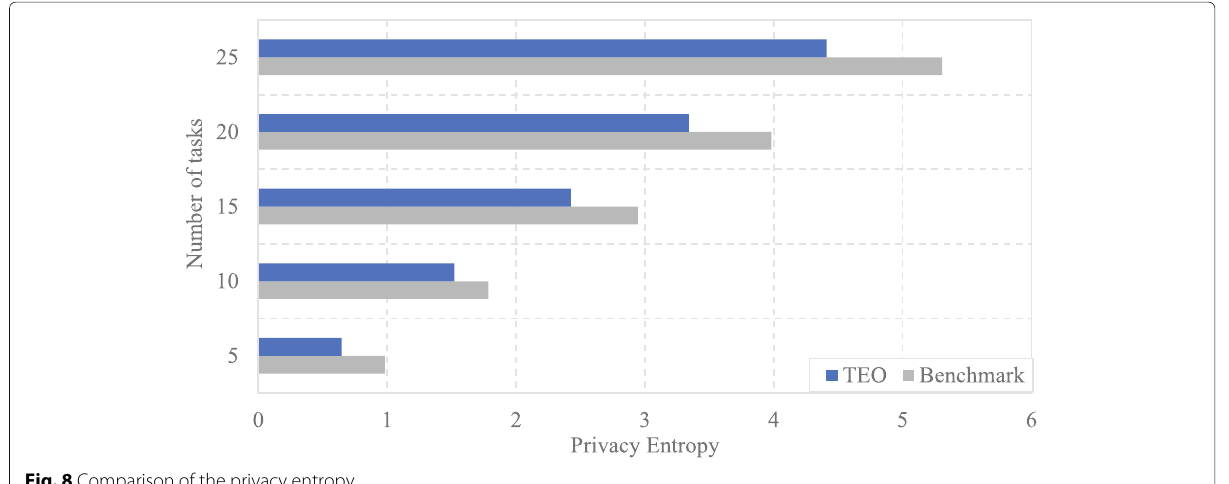
Fig. 8 Comparison of the privacy entropy